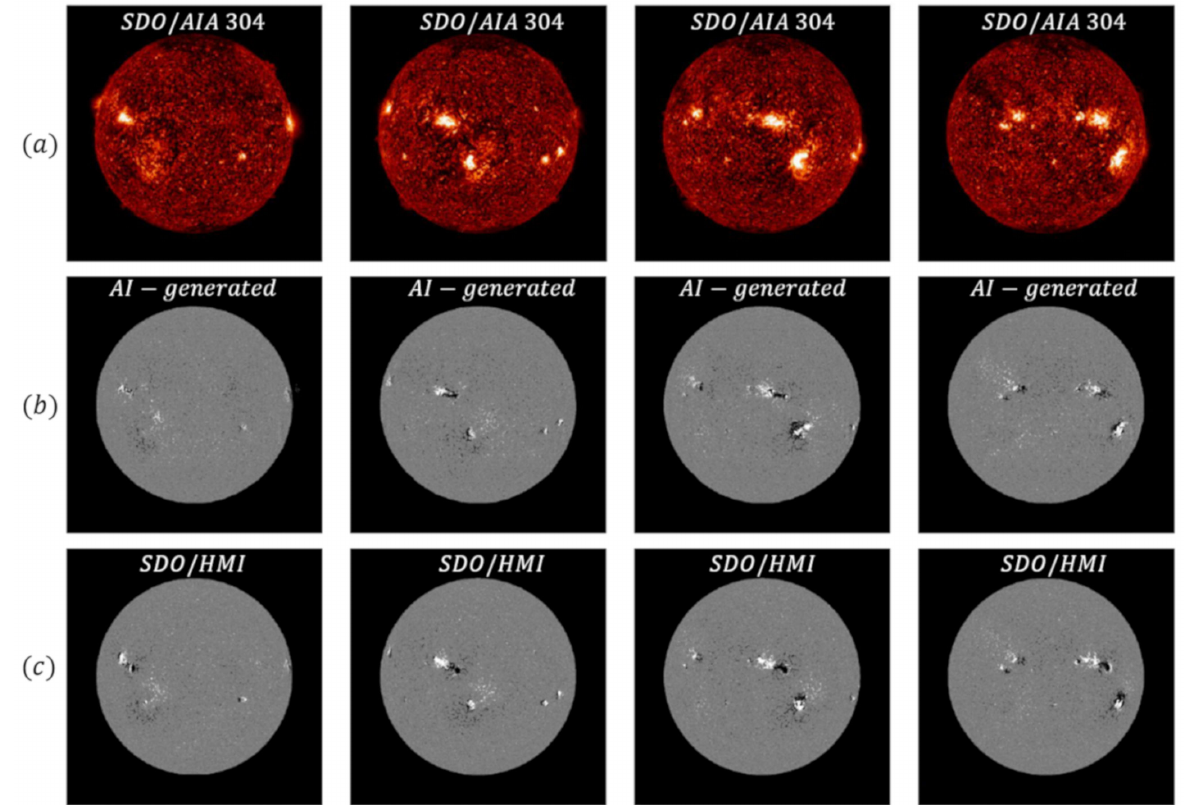
Figure 25. A lateral magnetic field image of the sun restored to the GAN [82]. ( a ) is an extreme ultraviolet image observed by a satellite, ( c ) is a magnetic field image observed by a satellite, and ( b ) is a side magnetic field image generated by a GAN.